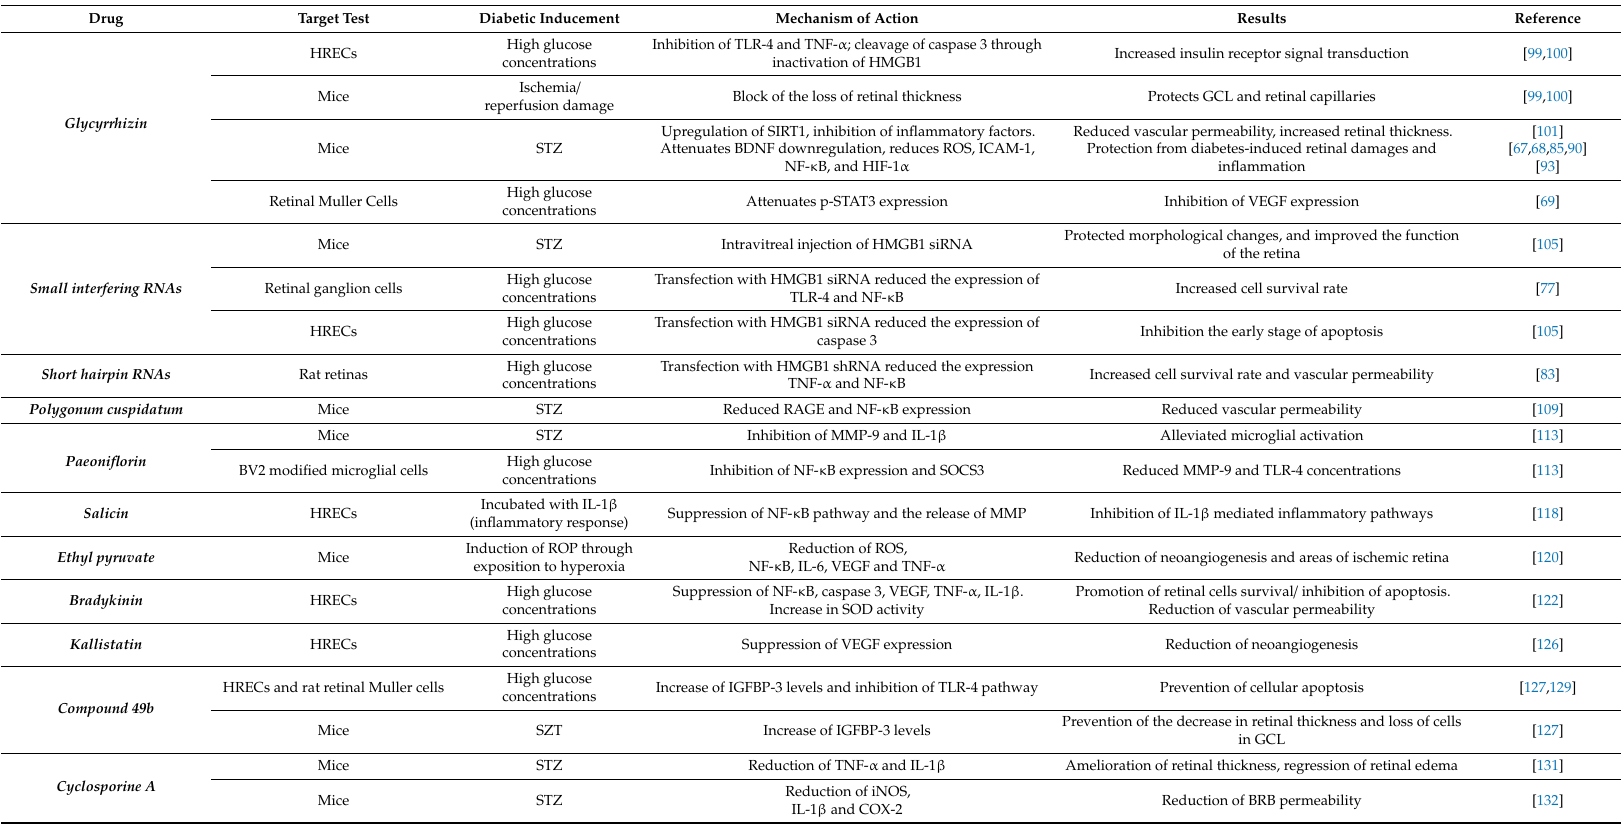
Table 1. Summary of direct and indirect high-mobility group box (HMGB1) inhibitors with therapeutic potential in diabetic retinopathy. HRECs = human retinal endothelial cells; TLR = toll like receptor; TNF- α = tumor necrosis factor- α ; GCL = ganglion cell layer; STZ = streptozotocin; SIRT1 = sirtuin 1; BDNF = brain-derived neurotrophic factor; ROS = reactive oxygen species; ICAM-1 = intercellular adhesion molecule-1; NF- κ B = nuclear factor- κ B; HIF-1 α = hypoxia induced factor-1 α ; pSTAT-3 = phosphorylated signal transducer and activator of transcription-3; VEGF = vascular endothelial growth factor; siRNA = small interfering RNAs; shRNA = short hairpin RNA; RAGE = receptors for AGEs; MMP = metalloproteinases; IL = interleukin; SOCS3 = suppressor of cytokine signaling 3; ROP = Retinopathy of prematurity; SOD = superoxide dismutase; IGFBP-3 = insulin-like growth factor-binding protein-3; iNOS = inducible nitric oxide synthase; COX-2 = cyclooxygenase; BRB = blood retinal